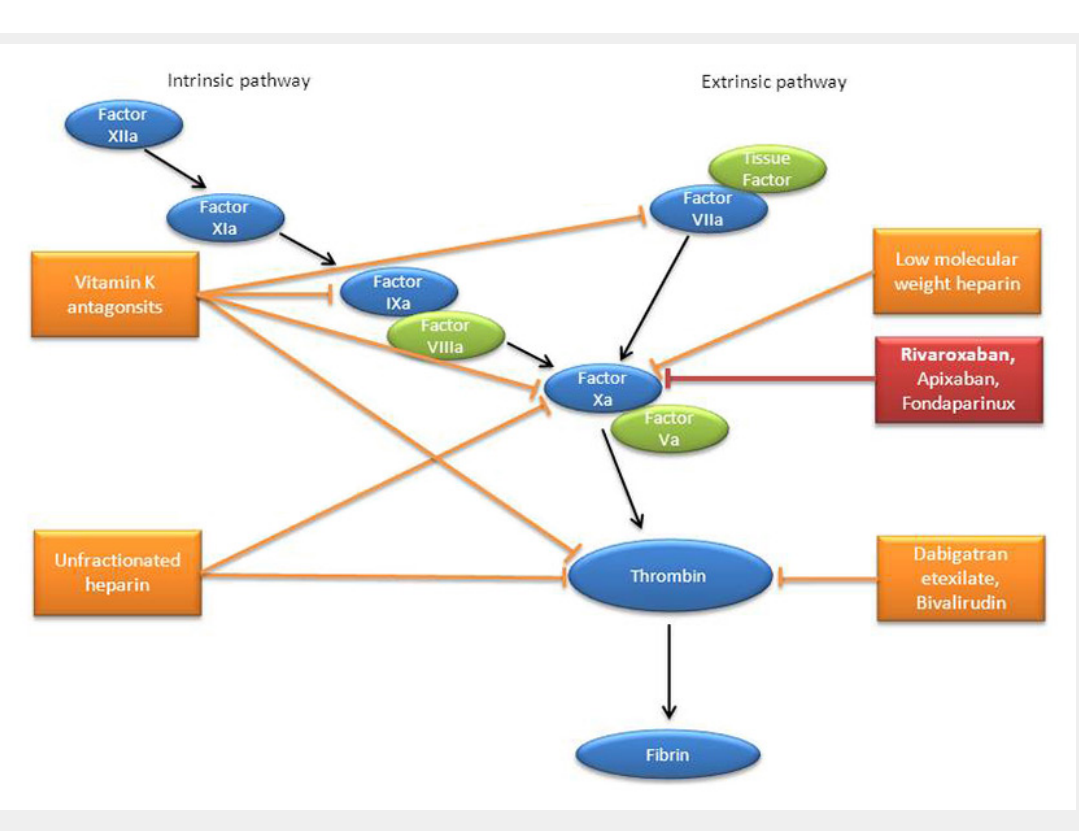
Figure 1 Schematic representation of the coagulation cascade with the sites of action of traditional and new anticoagulants. The cascade consists of the activation of subsequent coagulation factors (black arrows) in both the intrinsic and extrinsic pathways. The cascades converge upon the activation of factor Xa to a common path in which thrombin promotes the production of fibrin. The sites of inhibition of the various anticoagulants are shown by blunt